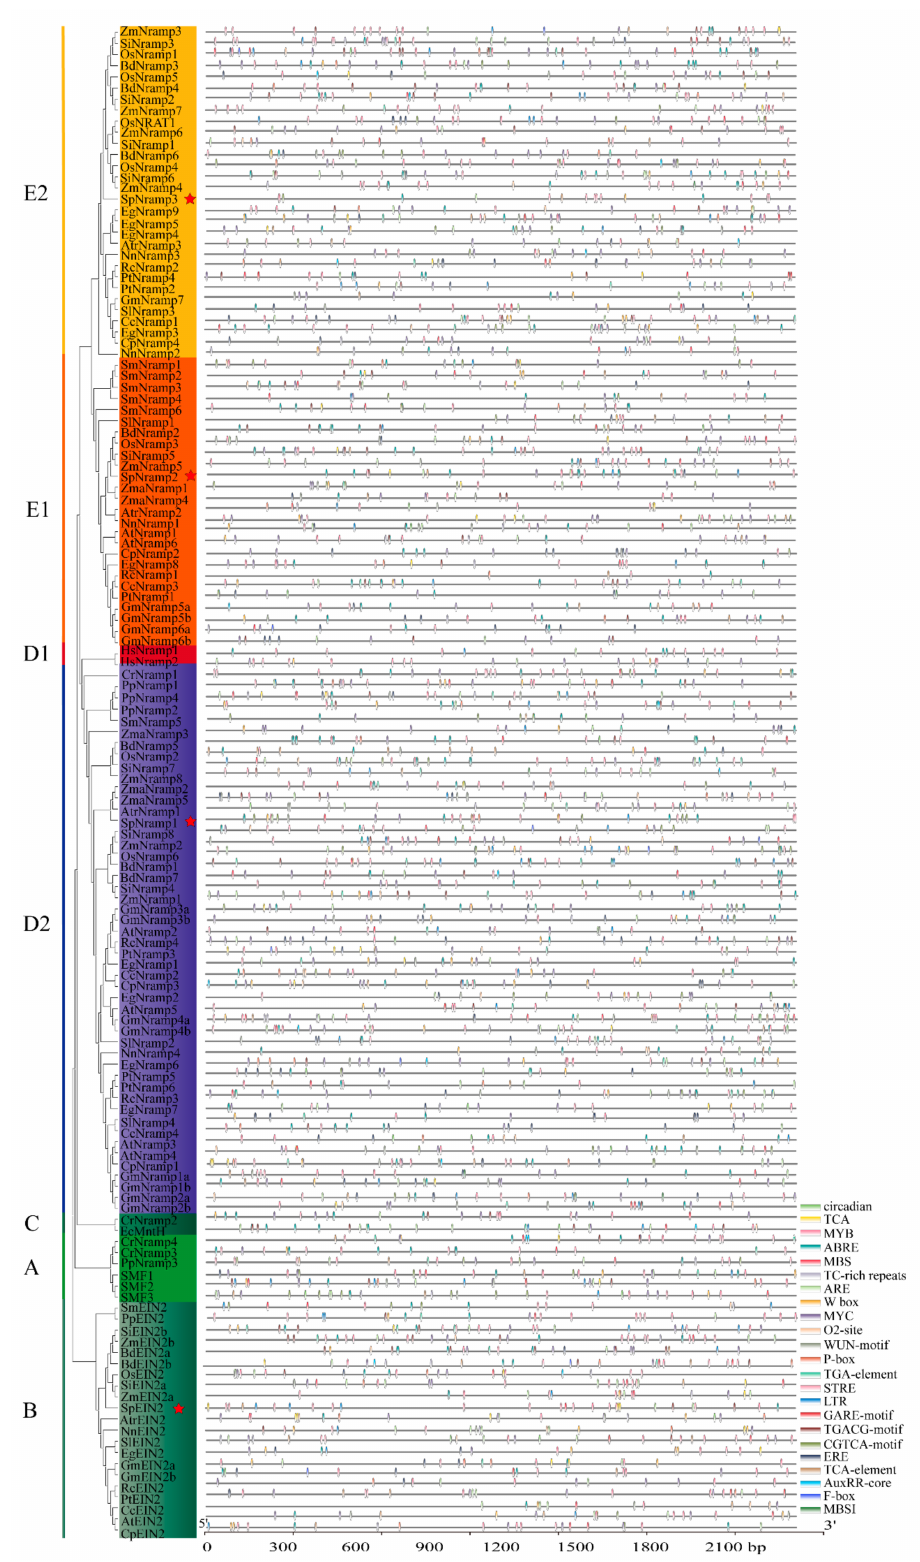
Figure 5. The cis-acting elements in the promoter regions in the 2000 bp upstream promoter in all selected Nramp genes are shown in the figure. The cis-acting elements were predicted by the online software PLANTCARE, and visualized using